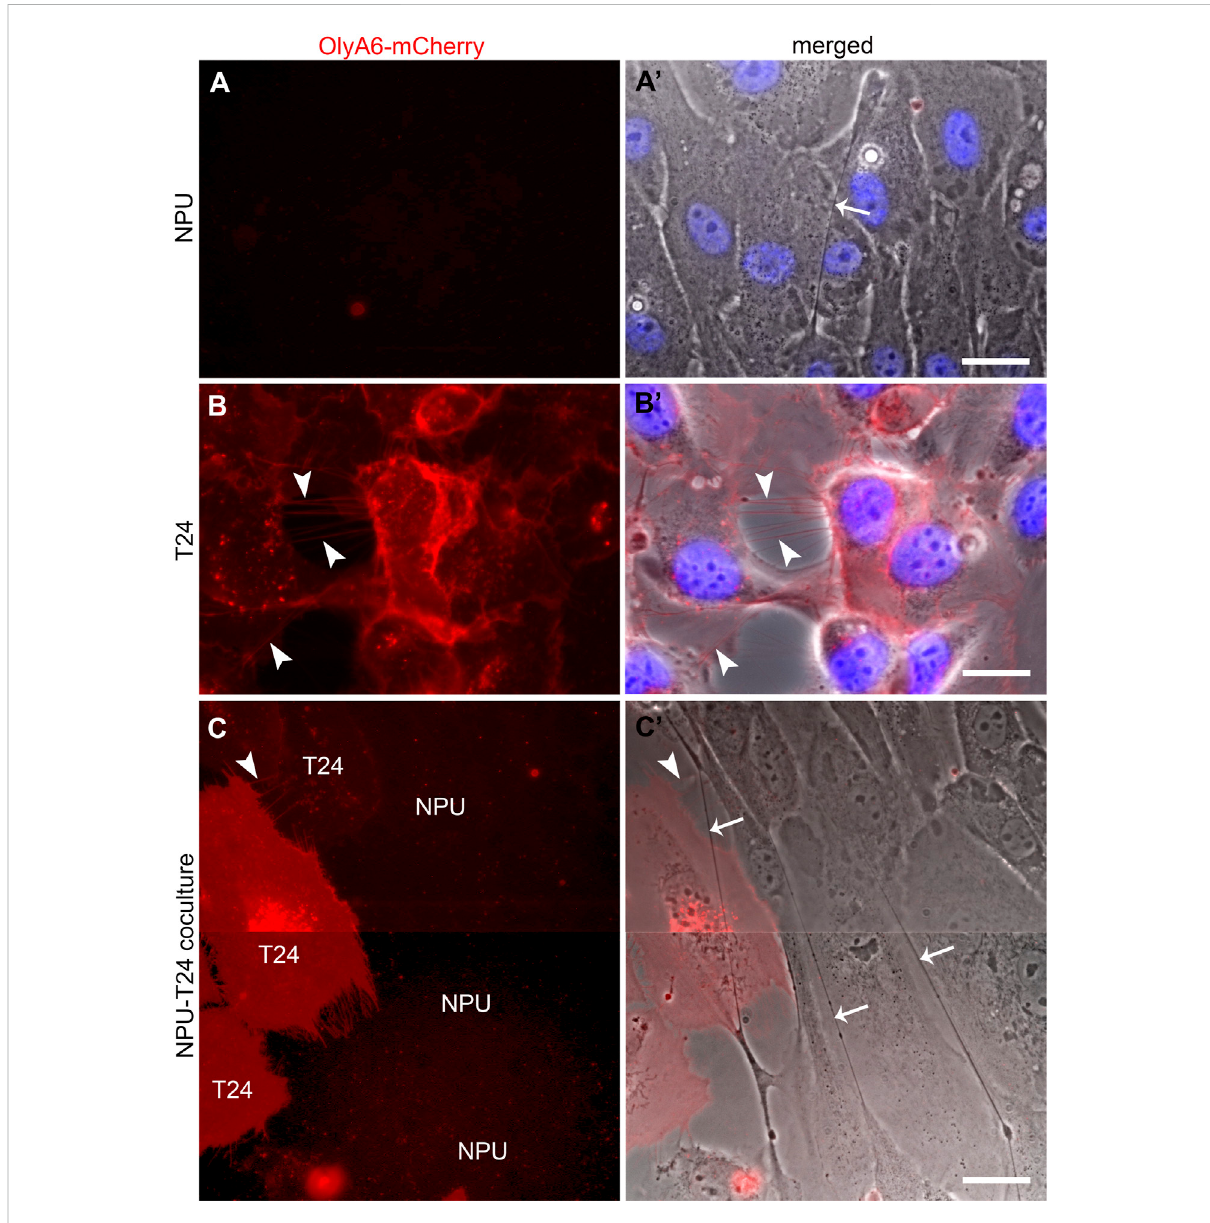
FIGURE 3 OlyA6-mCherry, a marker for cholesterol/sphingomyelin membrane domains, labels only TNTs of urothelial cancer (T24) cells. (A) OlyA6- mCherry does not label NPU cells in monoculture and their TNT, as shown in the merged image ( A ’ , arrow). (B) OlyA6-mCherry labels T24 cells and TNTs ( B and B ’ , arrowheads). Nuclei are labelled with Hoechst. (C) In cocultures, T24 cells are discriminated from NPU cells due to the af fi nity of OlyA6-mCherry to label only T24 cells and their TNTs ( C and C ’ , arrowhead shows the array of TNTs). NPU cells and their TNTs are not labelled withOlyA6-mCherry( C ’ ,arrows).BecausetheascendingnatureoftheTNTs,thecellsarenotperfectlyinfocusinthecompositeimage.Imageswere acquired with a fl uorescence phase-contrast fl uorescence microscope. Scale bars: 20 μ